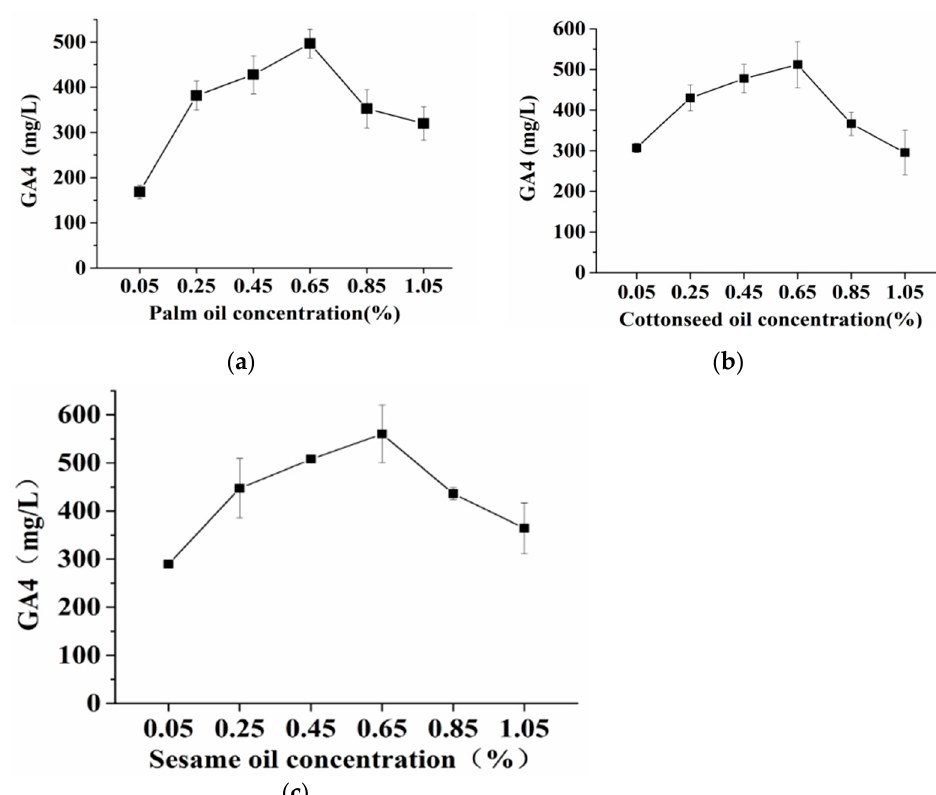
Figure 1. Effect of different vegetable oils on GA4 production by G. fujikuroi QJGA4-1.